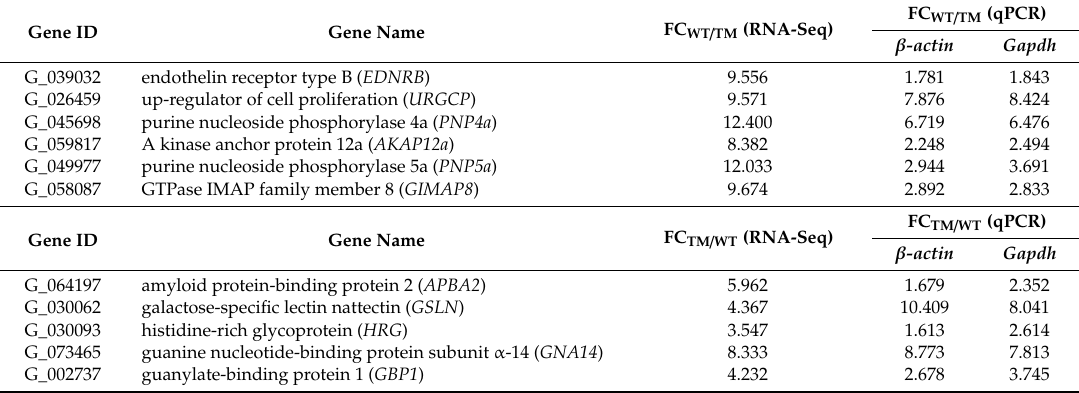
Table 6. Comparison of relative qPCR results with RNA-Seq